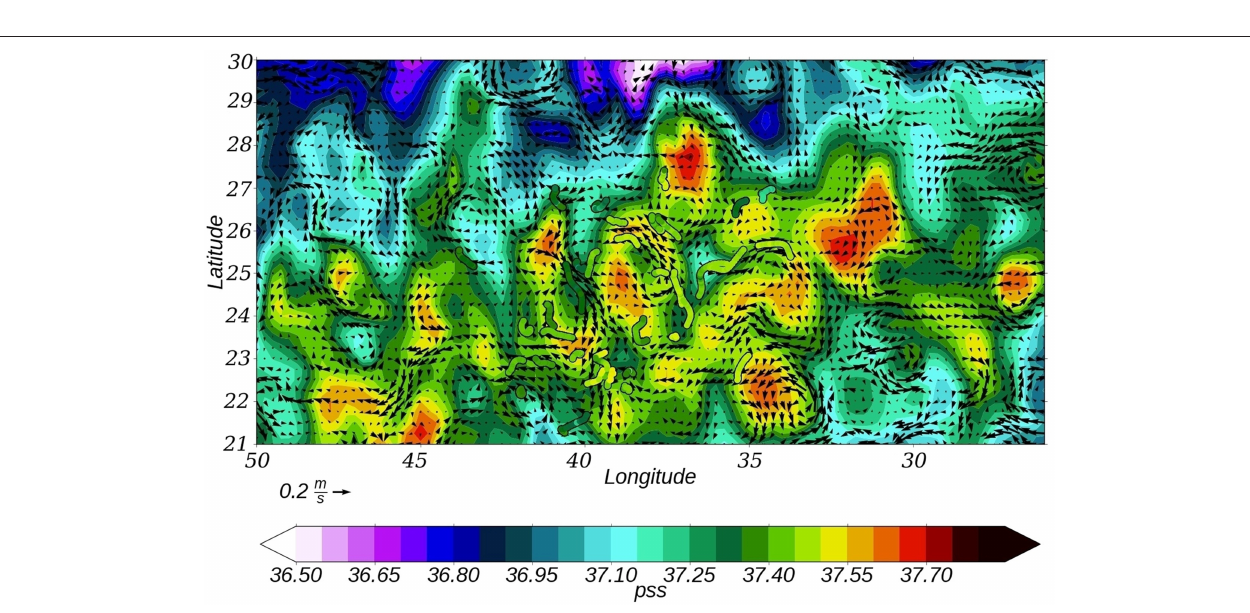
FIGURE 2 | RMS differences at drifter positions (in pss) over the SPURS domain between drifters SSS and 10-day CEC-CATDS SMOS SSS product (black), SMOS-OI with (green) SSH or without (red) constraint.